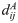
The arc-cosine distances dijA toward the USA versus time, for each of the 11 countries analyzed, t ∈ [1960, 2015].The clusters C1 = {AUS, CAN, CHE, FRA, GBR, JPN, USA} and C2 = {BRA, CHN, IND, MEX, ZAF} are visible.